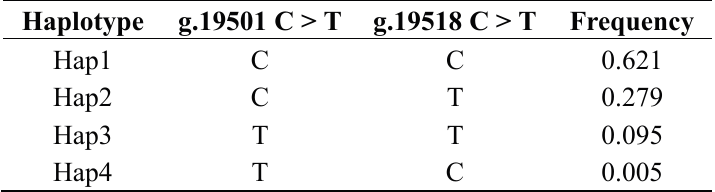
Table 4. Haplotypes of SIRT2 gene and their frequencies in Qinchuan